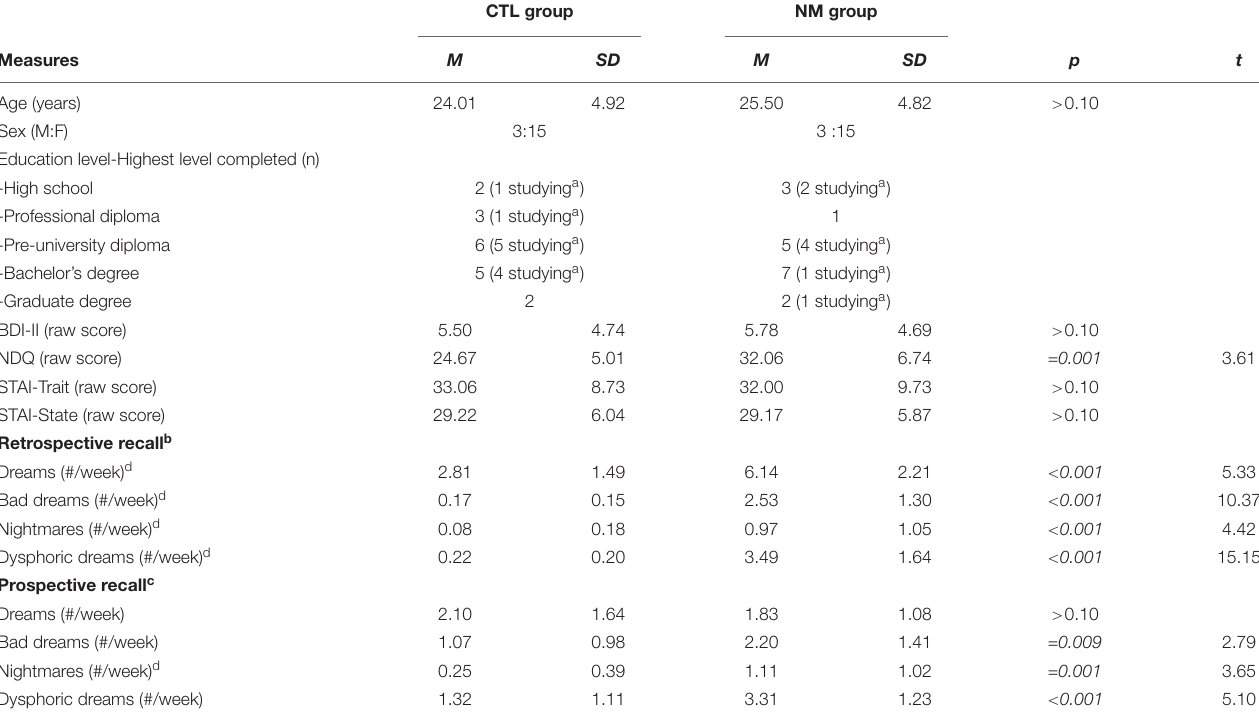
TABLE 1 | Participant